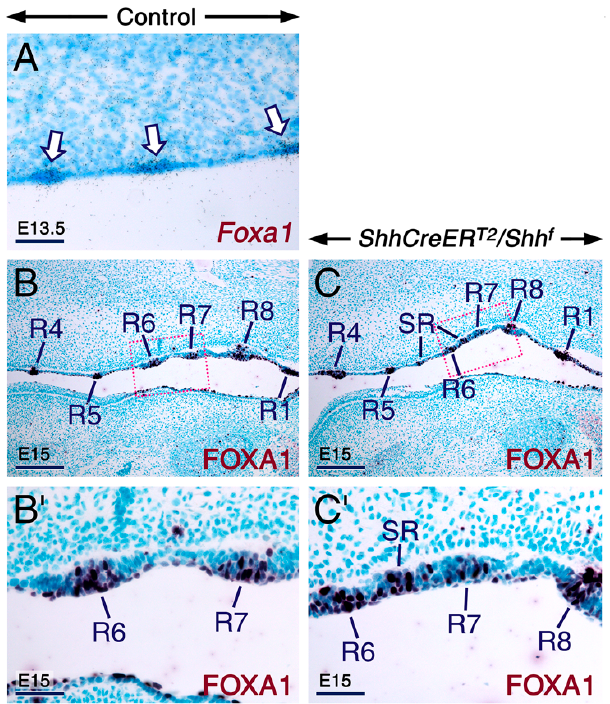
Figure 5. Loss of SHH signaling in the ShhCreER T2 / Shh f mutant palate causes mispatterning of rugae palatinae ( A ) Bright-field view of a frontal section across the palate of an E13.5 control embryo after in situ hybridization with a 35 S-UTP-labelled Foxa1 riboprobe showing Foxa1 expression (black dots) in rugae palatinae (arrows). ( B , C ) Representative FOXA1 immunostaining (dark purple) of para-sagittal sections of palates (anterior palatal region towards the left of the panels) from E15 control ( B ; n = 3) and ShhCreER T2 / Shh f mutant ( C ; n = 3) embryos first exposed to tamoxifen at E10.5-E11. B’ and C’ are magnified views of the boxed areas in B and C , respectively. In the control palate FOXA1 is detected in the palatal periderm and in a subset of cells of rugae palatinae . The orthotopic rugae (R) are labelled with arabic numerals according to the order of their formation as described previously [91]. In the mutant palate supernumerary rugae (SR) develop between rugae R5 and R6 and between rugae R6 and R7 ( C , D ). Scale bars: 200 µ m ( B , C ) and 50 µ m ( A , B’ , C’